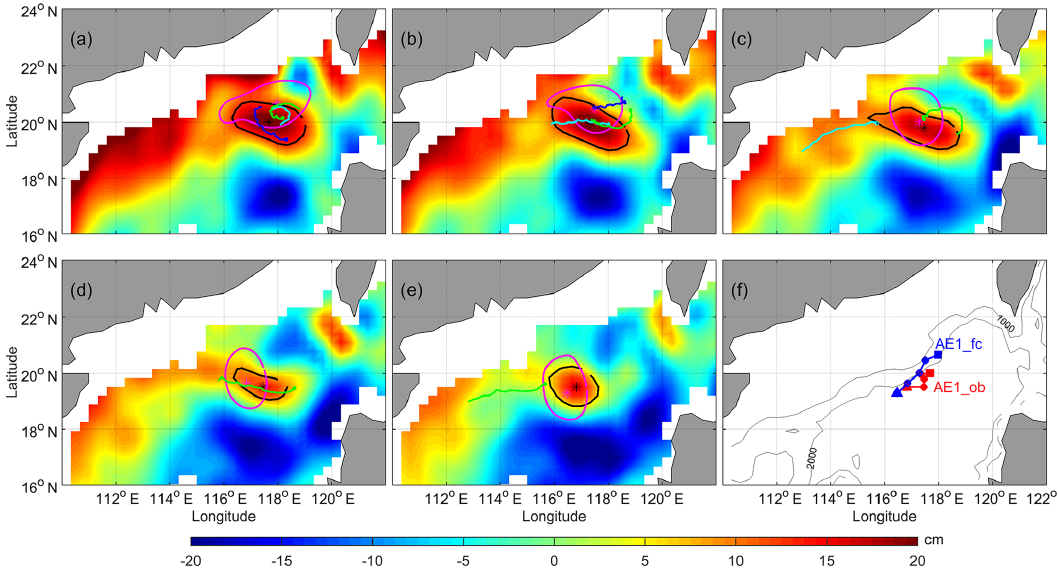
Figure 8. Comparison of AE1 of Exp1 to observation, and trajectories of drifter buoys during the 29 November 2003 and the 29 Decem- ber 2004. The cyan, green, and blue solid dots and lines indicate the start positions and trajectories of numbers 22917, 22918, and 22610 drift buoys during the corresponding period, respectively. Where, the red (blue) dotted line in (f) is the path of AE1 derived from observation (forecast) SLA during the experiment period, the square (triangle) represents the start (end)